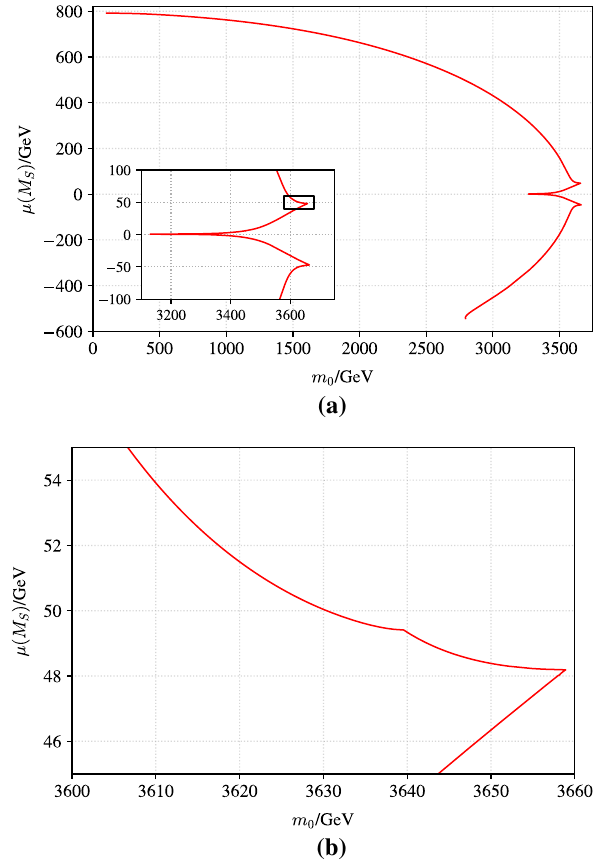
Fig. 4 A scan over μ with output m 0 for the low-energy input param- eters { M Z , G F } and the CMSSM parameters given in Eq.(9). In order to make all kinks visible, the boxed region in ( a ) is enlarged and shown in ( b